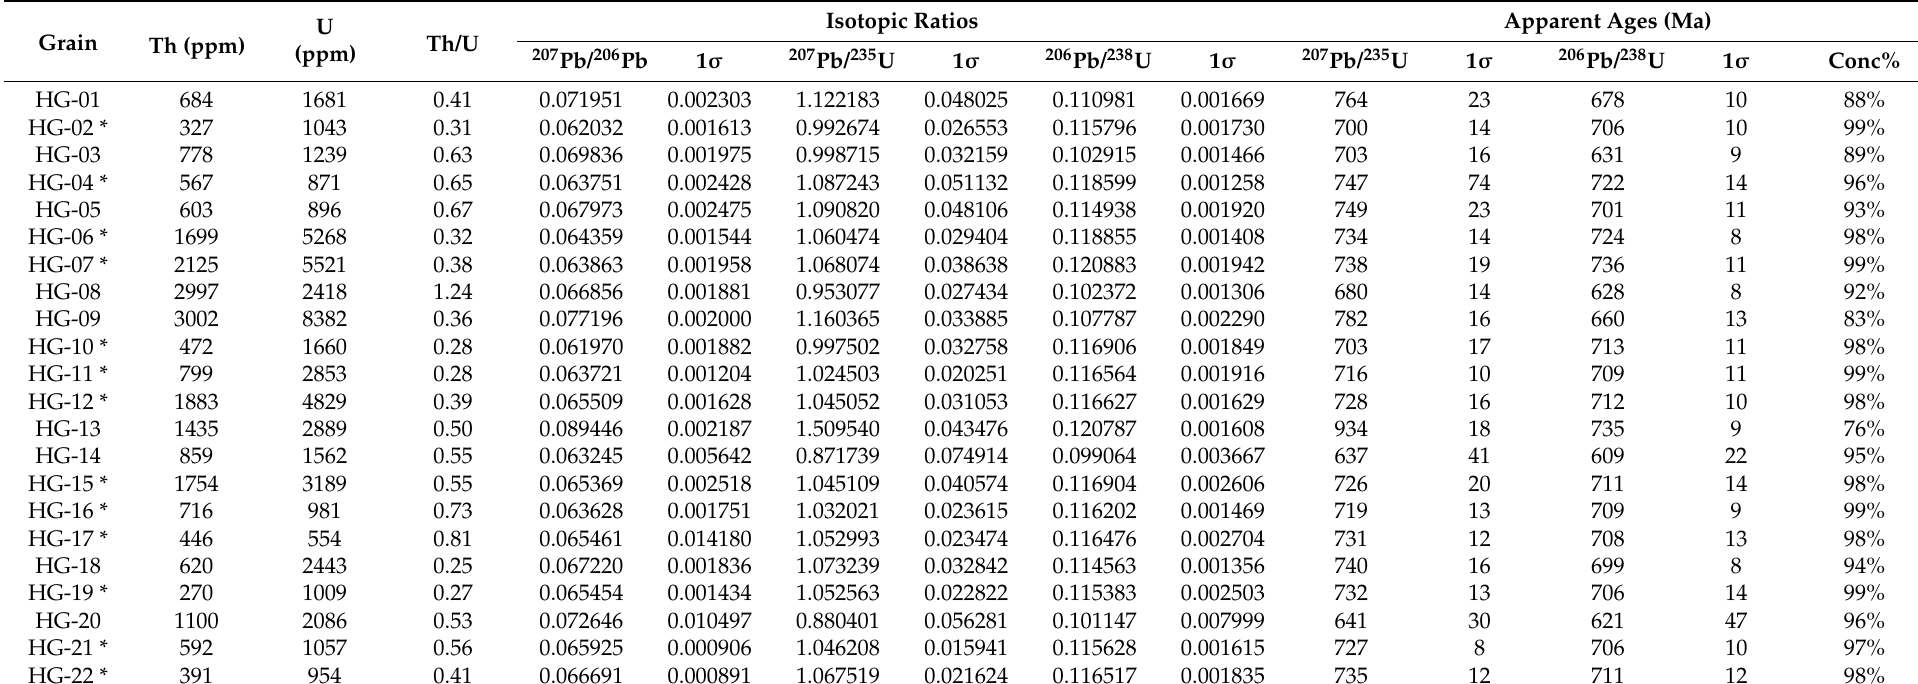
Table 1. Zircon U-Pb isotopic dating data from the Haweit granodiorites, NE